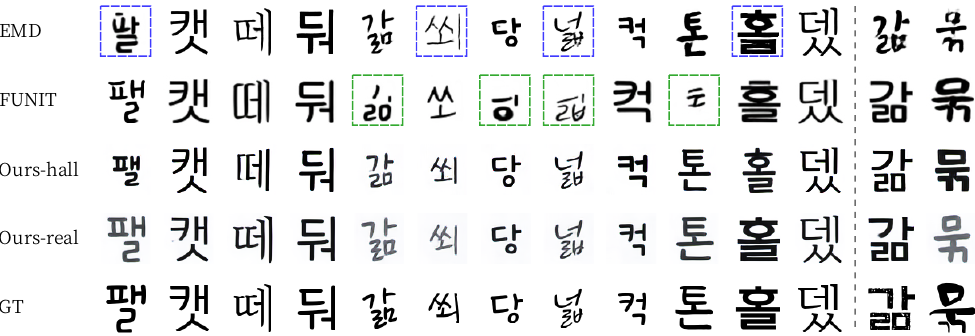
Figure 12. Examples of Korean unseen font style generation. The presented characters were not shown in the training phase. The last two columns show some failure